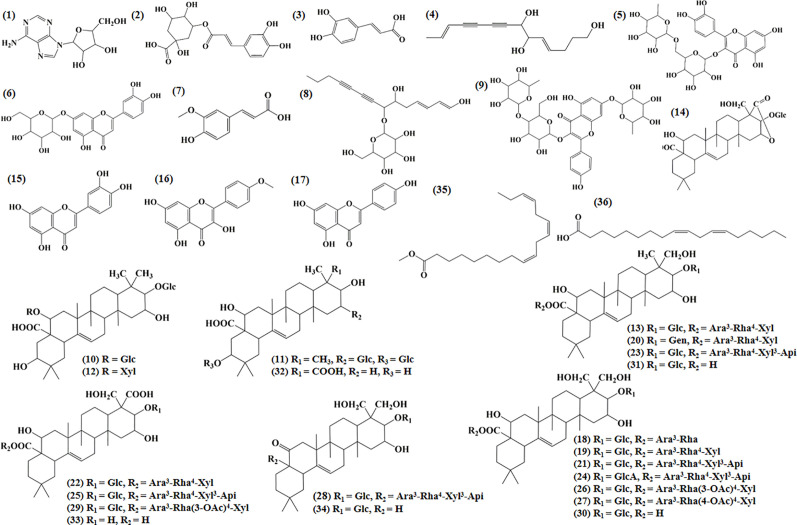
Structural of compounds in Platycodon grandiflorum (PG).